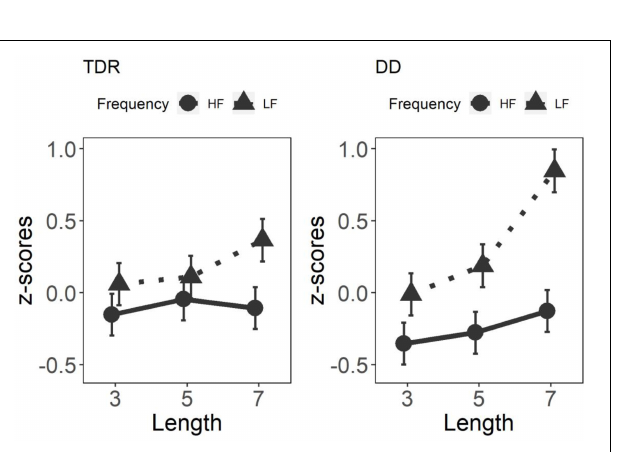
FIGURE 2 | Three-way interaction on z -scores on words. Higher z -scores reflect lower performance. TDR, typical developing readers; DD, developmental dyslexics; HF, high frequency; and LF, low